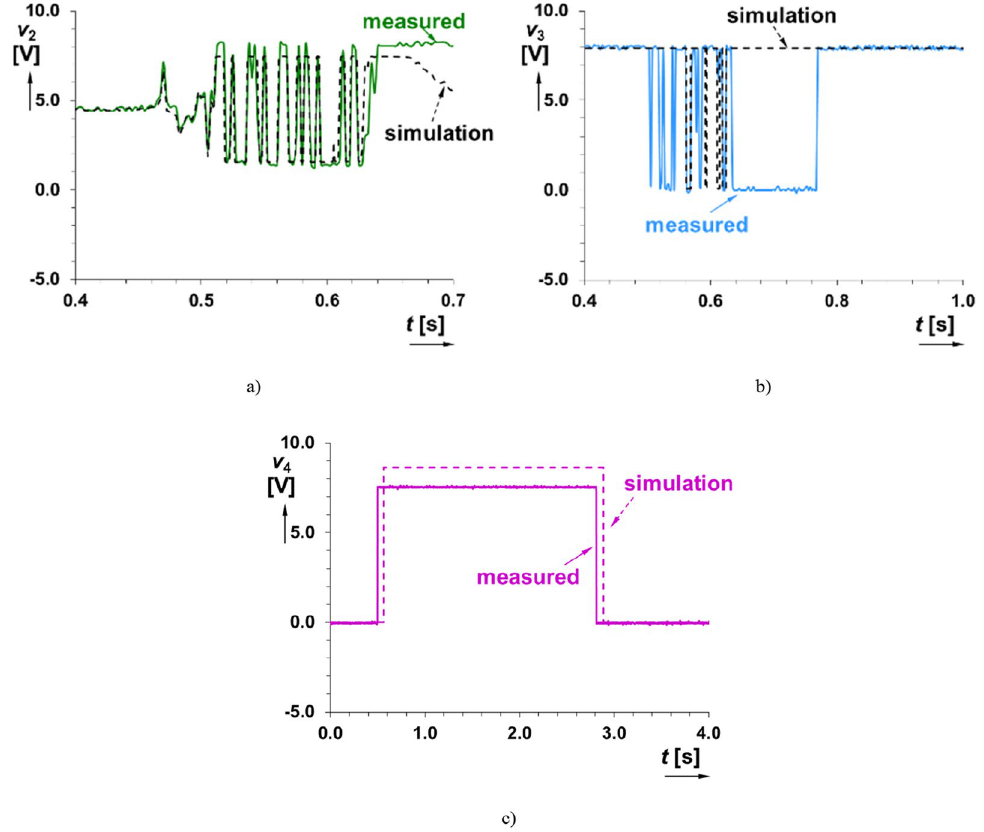
Figure 9. Comparison of simulated and measured time domain response of the readout system on direct hit on microphone (intentionally limited and overridden): ( a ) v 2 ( t ), ( b ) v 3 ( t ) and ( c ) v 4 ( t